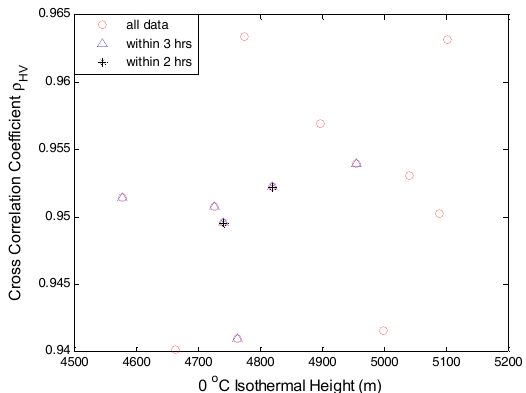
Figure 7. Scatter plot between the 0 ◦ C isothermal height and the corresponding ρ HV value for convective rain melting layer.